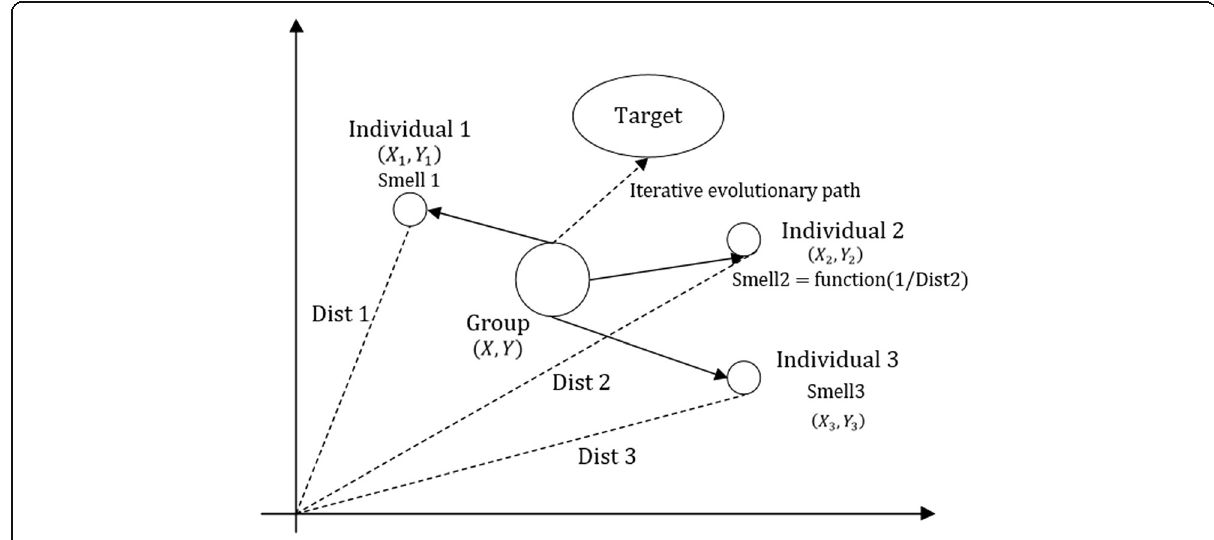
Fig. 1 Iterative foraging diagram of Apriori algorithm. Figure 1 shows the visual representation of its iterative